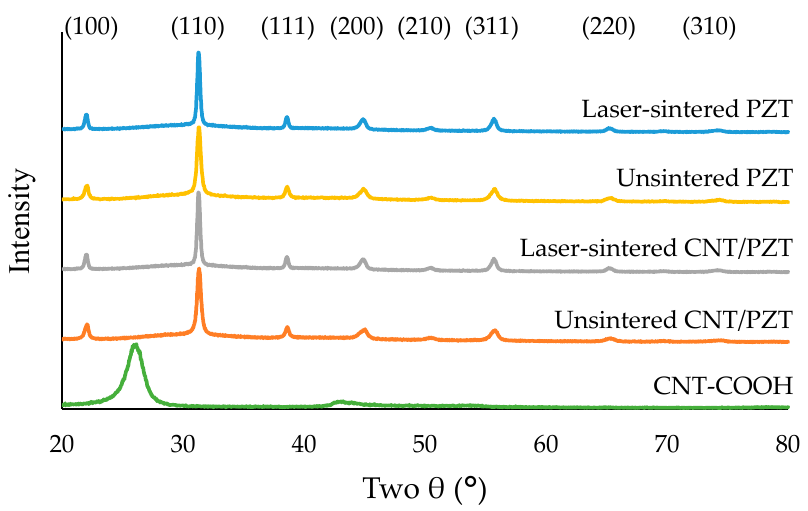
Figure 11. XRD spectra of the laser-sintered and unsintered PZT and CNT/PZT, as well as CNT- COOH.